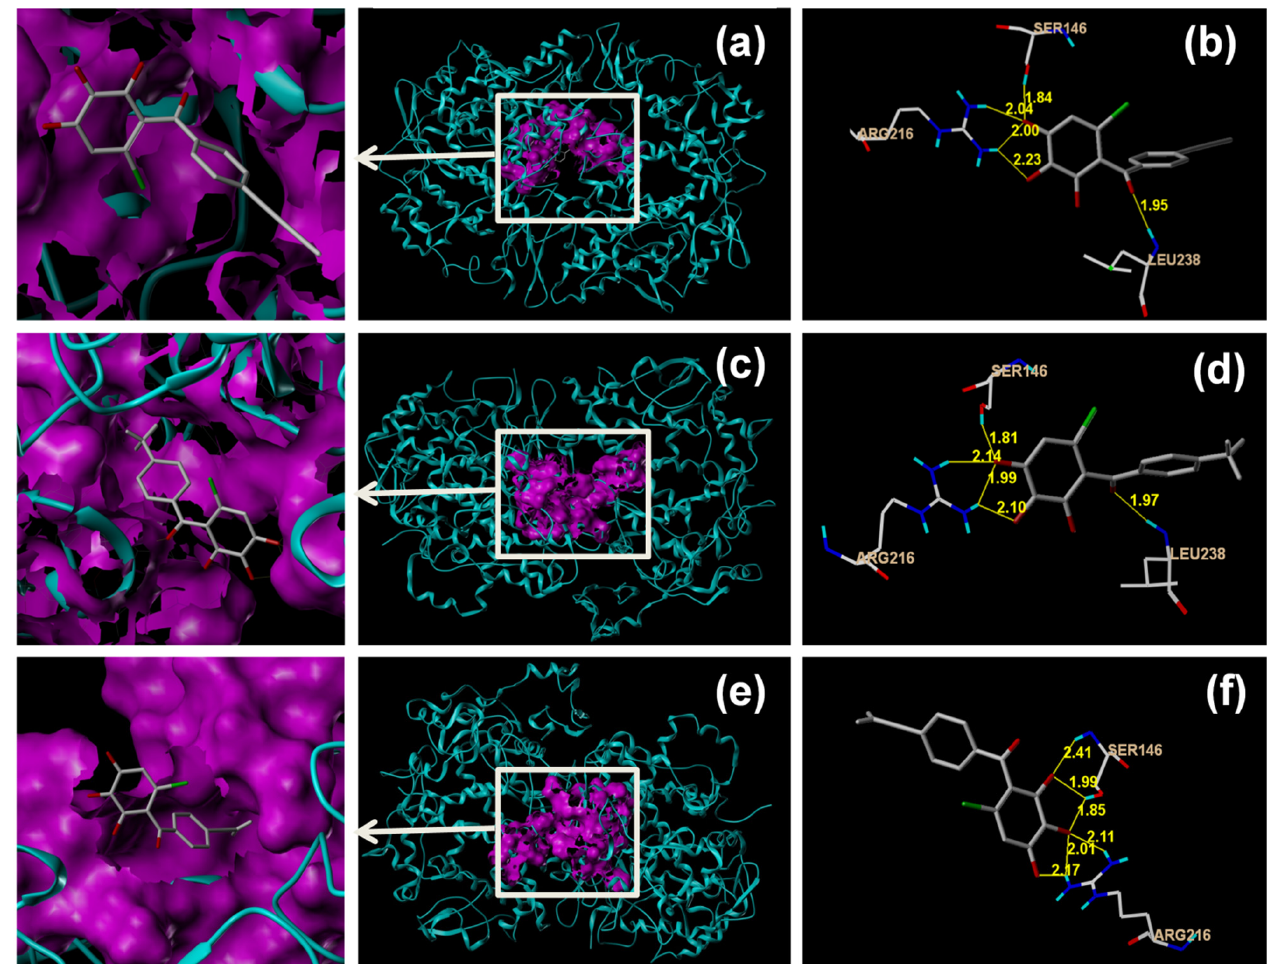
Figure 3. 3D putative binding complexes and hydrogen bonding of compounds DB2 ( a , b ), SC2 ( c , d ) and YB2 ( e , f ) with the COX2 enzyme (PDB code 5f1a). (COX2 is shown as cyan ribbon; The ligand surface is indicated in purple; Compounds DB2, SC2 and YB2 are shown in capped sticks models; The amino acids involved in hydrogen bond contact are shown in line models; Hydrogen bonding are yellow lines).